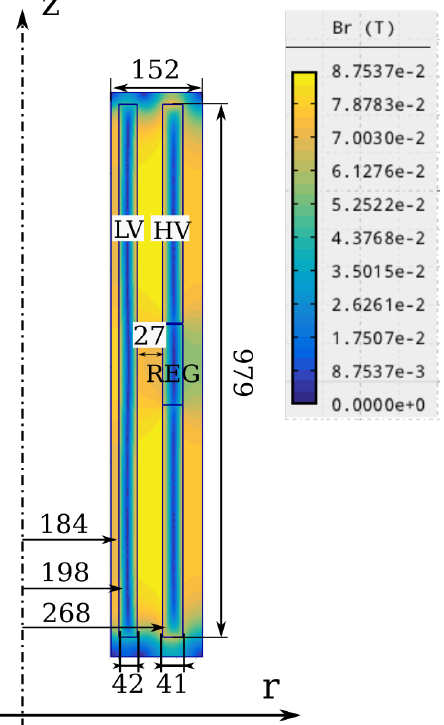
Figure 5. Main dimensions and the flux density distribution of the validation example and the main parameters in Agros2D